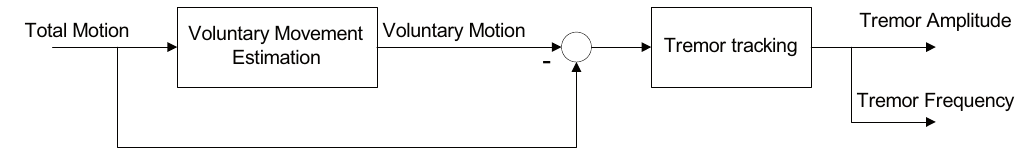
Figure 5 . Block diagram of the two stage algorithm for real-time estimation of tremor parameters. First, we generate an estimation of the voluntary component of motion, which subtracted from the total move- ment yields an estimate of tremor. Afterwards, in stage two, and adaptive algorithm tracks instantaneous tremor